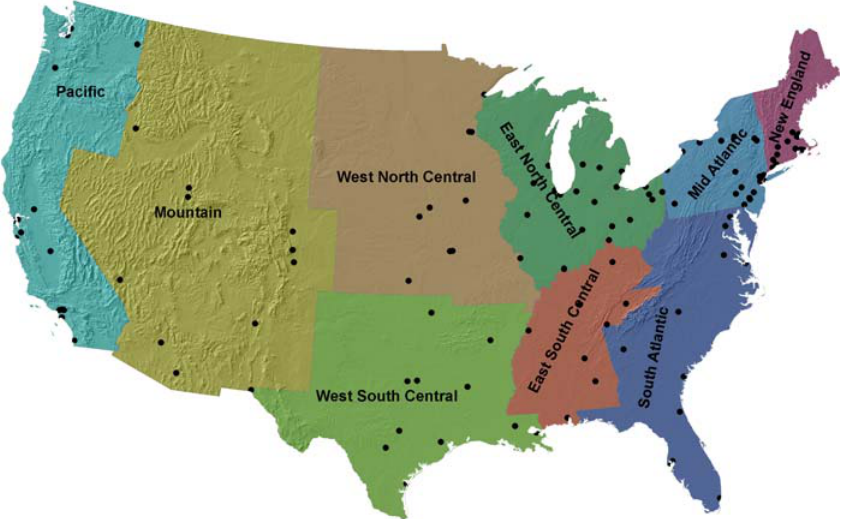
Figure 2. Major Geographic Regions of the United States The sentinel cities that report mortality due to P&I used in the Centers for Disease Control and Prevention 122 Cities Mortality Reporting System are displayed (black dots). Because the strength of the seasonal influenza cycle is weak for cities with small case counts and because some city data contain missing data points, we aggregated the raw city-level data to obtain composite waveforms by major geographic region, the aerial unit of analysis for this study. DOI: